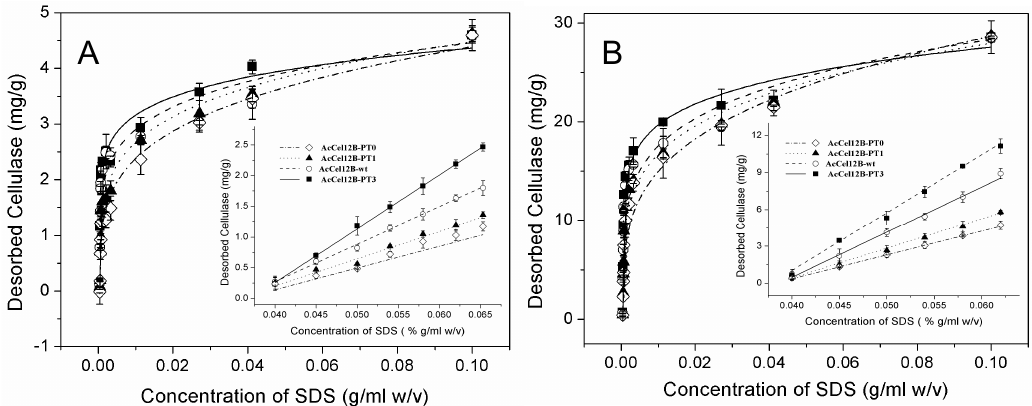
Figure 5. Desorption of AcCel12B and its mutants from Avicel and RAC. ( A ) Desorption of cellulases from Avicel. ( B ) Desorption of cellulases from RAC. The concentration of desorbed proteins was measured by A280nm, calculated, and fitted in Equation (2). The amount of cellulases desorbing from cellulose under low SDS conditions was linearly fitted. All figures were described as AcCel12B ‐ PT0 (dashed dotted line and ◊ ), AcCel12B ‐ PT1 (dotted line and ▲ ), AcCel12B ‐ wt (dashed line and ○ ), and AcCel12B ‐ PT3 (solid line and ■ ). Table 4. Linear fitting curve parameters of desorption of AcCel12B and its mutants at low SDS concentrations (0.04–0.065% g/mL).